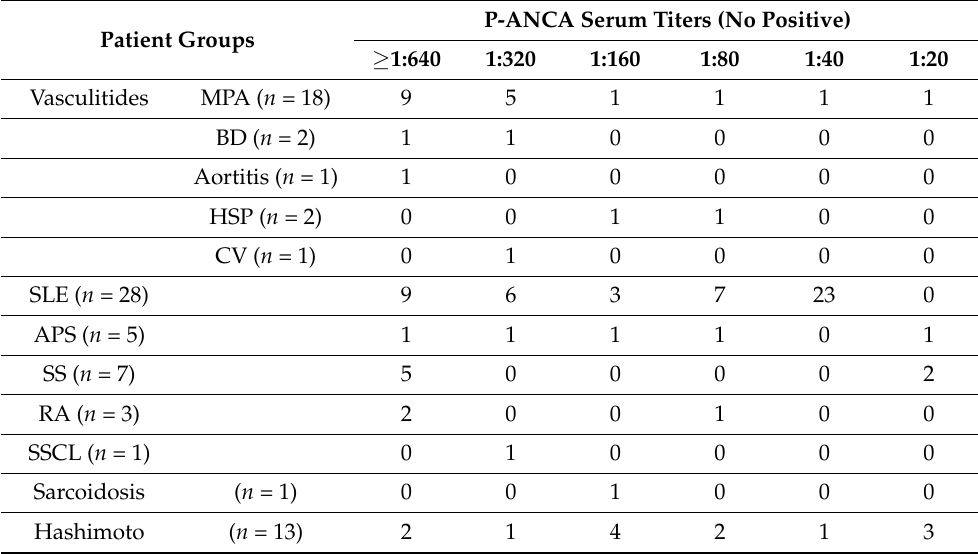
Table 1. Serum P-ANCA titers in the various P-ANCA-positive autoimmune disease patients studied. Patient Groups